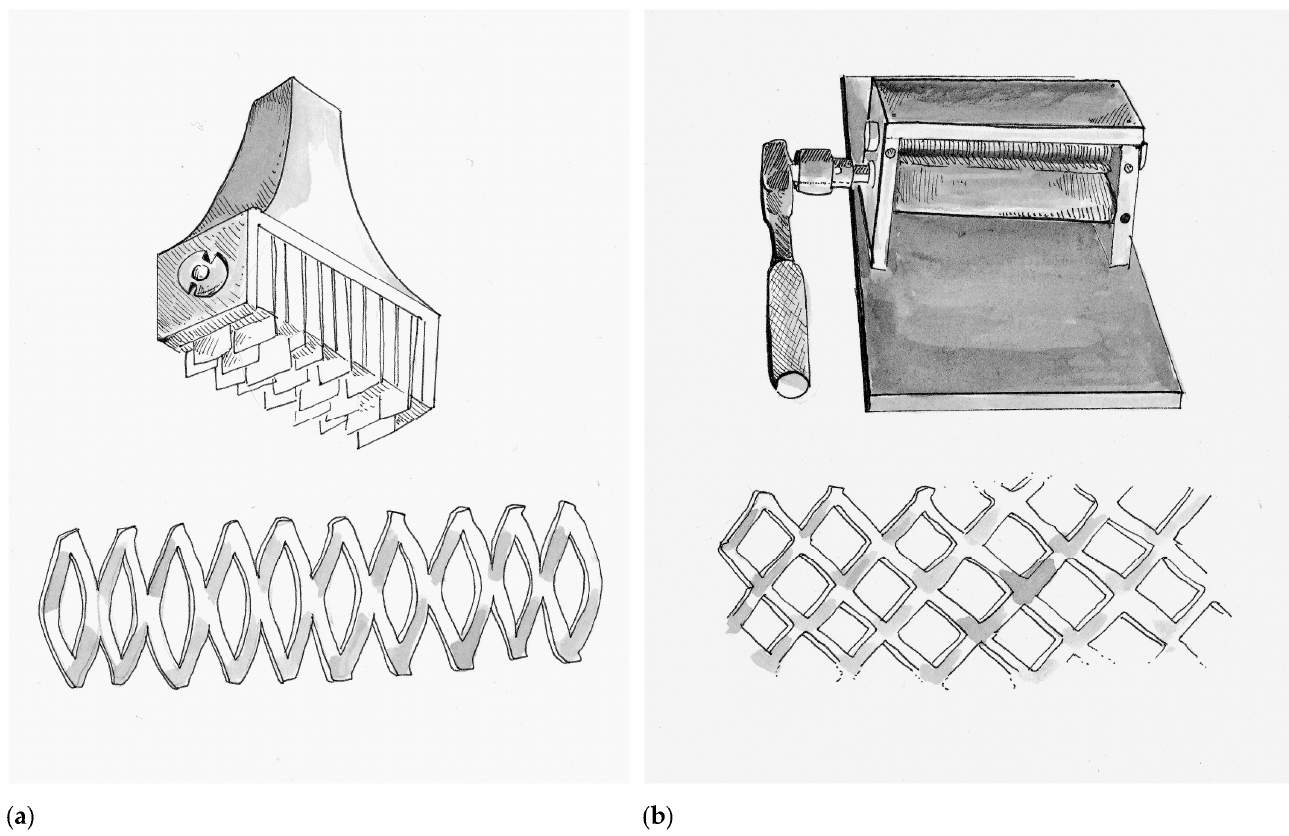
Figure 4. Instruments for skin graft expansion: ( a ) The Hautschlitzapparat by Lanz in 1907; ( b ) The Tanner–Vandeput mesh-dermatome in 1964.